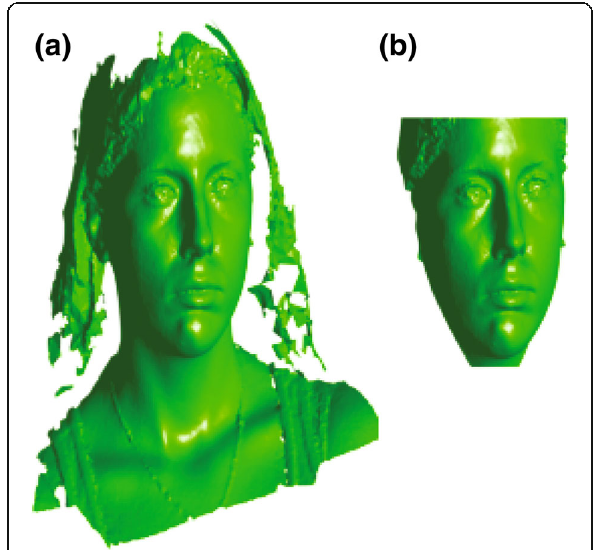
Fig. 3 Mesh clipping with Slicer software, a sample mesh before clipping ( a ) and after clipping all excess structures ( b